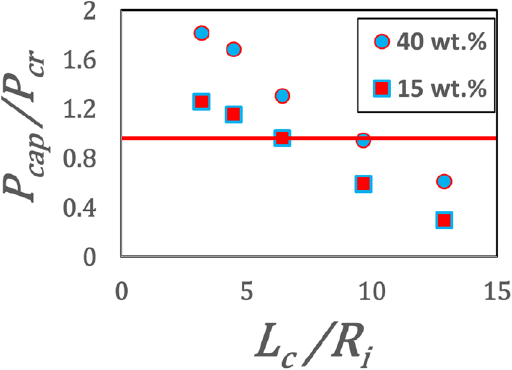
Figure 5. Buckling Criteria. Ratio of capillary pressure and critical pressure required for buckling for various normalized channel lengths ( L c ). R i ≈ 1.52 is the initial droplet meridional radius. Red line marks the transition from buckling ( > 1) to non-buckling regime ( <